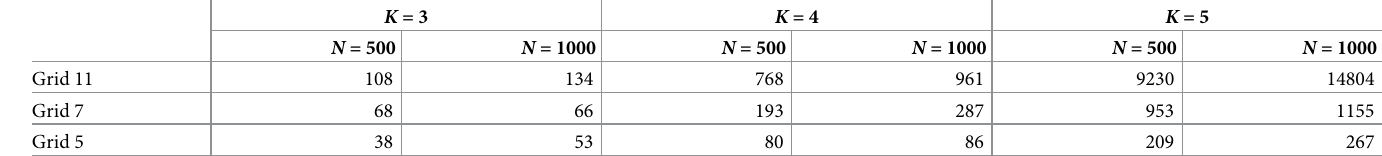
Table 2. The average CPU time in seconds of IEML1 with Gird11, Grid7 and Grid5 under K = 3, 4, 5 with sample size N = 500,